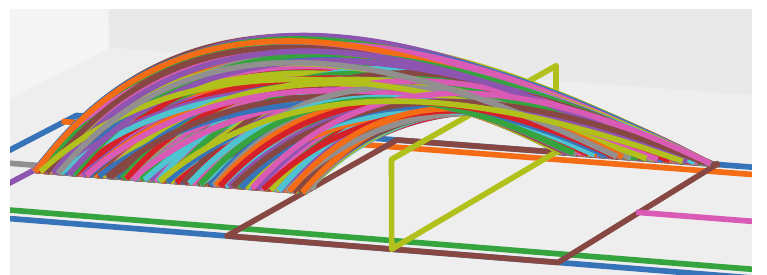
Figure 4. Five thousand good serves launched (trajectories from right to left) with randomized launch positions, directions and speeds from the serve height of 1.02 m.